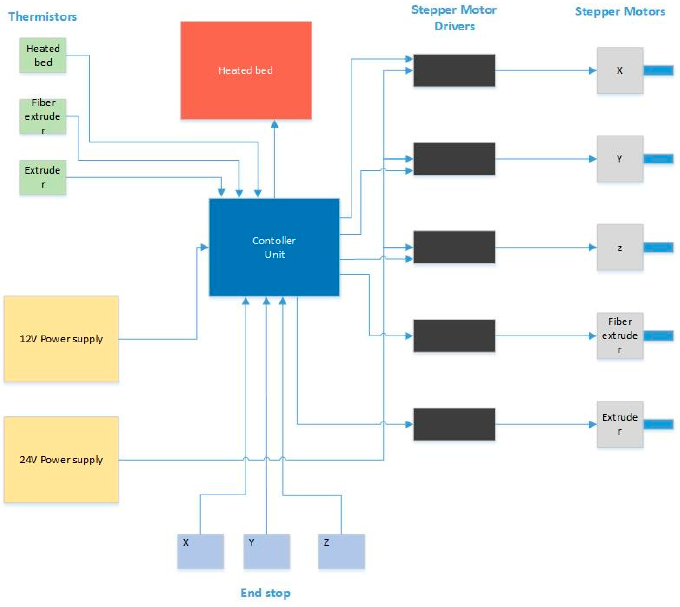
Figure 2. FFF prototype equipment electronic diagram.